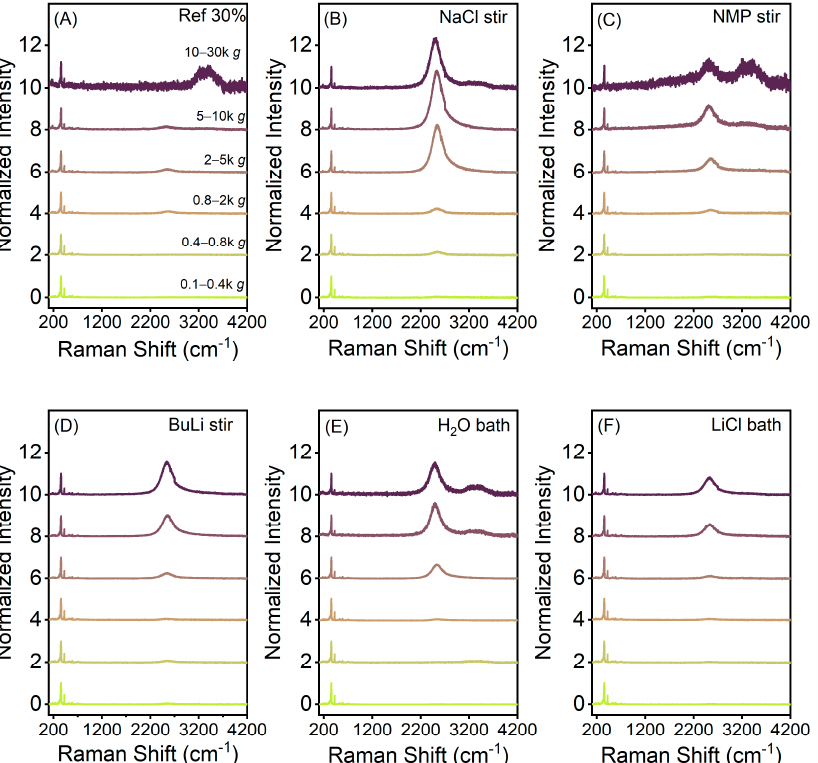
Figure A3. Raman spectra of WS 2 nanosheet dispersions, exfoliated by tip sonication with 30% amplitude. The bulk WS 2 powder was subjected to the different pretreatments, prior to exfoliation. ( A ) Reference, ( B ) stirring in H 2 O/NaCl, ( C ) stirring in NMP, ( D ) stirring in hexane/ n ‐ BuLi, ( E ) bath sonication in H 2 O, ( F ) bath sonication in an H 2 O/LiCl. The spectra display the characteristic Raman signals of WS 2 . The PL of WS 2 is displayed around 2500 cm − 1 and negligible in dispersions containing large nanosheets but increases with the ML content of the dispersion. Signals around 3400 cm − 1 originate from water. The spectra of the different nanosheet sizes are vertically offset for clarity.